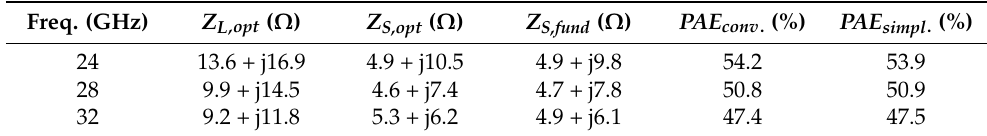
Table 1. Simulation comparison between the conventional and simplified fundamental load-pull procedures for the stabilized 46 × 8 µ m cell with the purpose of achieving the maximum PAE. Freq. (GHz)